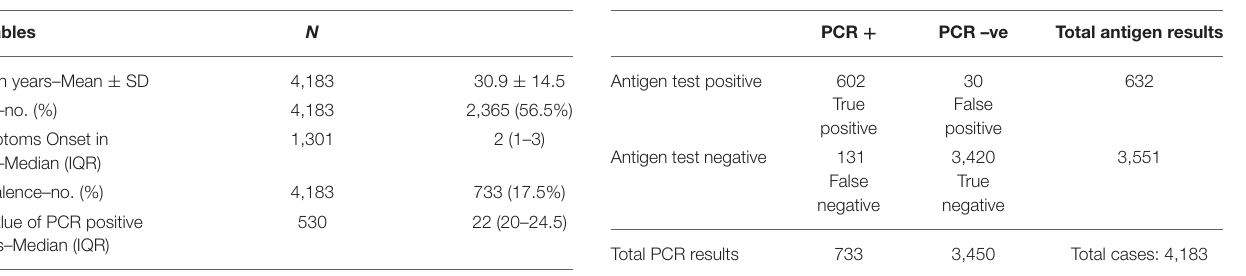
TABLE 1 | Demographics and clinical features of studied sample. TABLE 2 | 2 × 2 table showing the PCR and Antigen test results.